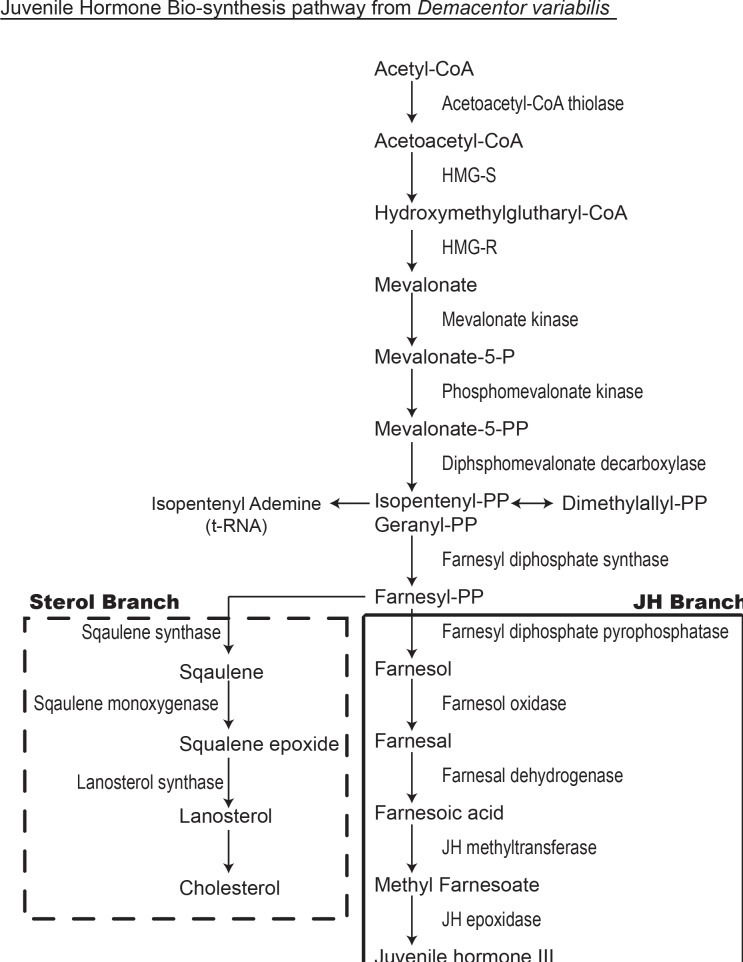
Juvenile hormone III and cholesterol bio-synthesis pathways in insects, modified from Bellés et al.[38].